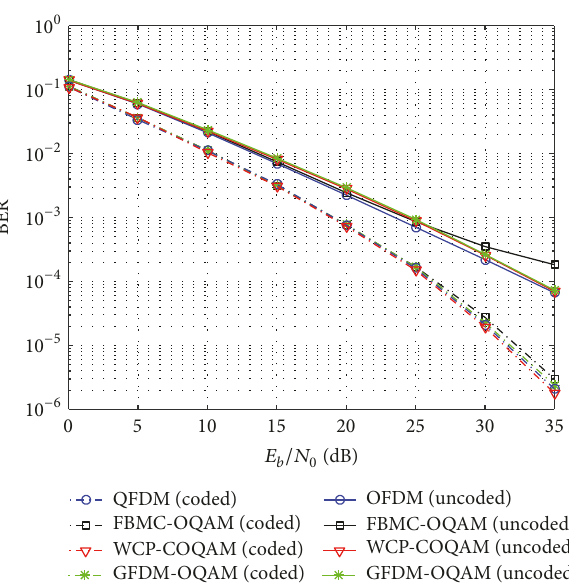
Figure 10: BER curves of the analysed MCM systems in a multipath channel. We employed turbo encoding/decoding with soft decoding and a code rate of